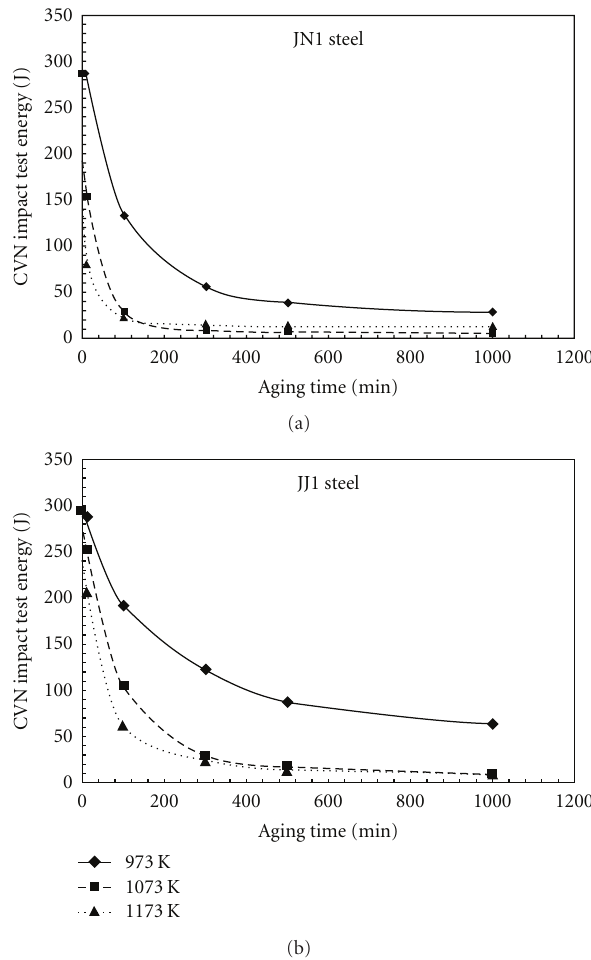
Figure 9: CVN fracture energy at 77K as a function of aging time for (a) JN1 and (b) JJ1 steels aged at 973, 1073, and 1173 K.